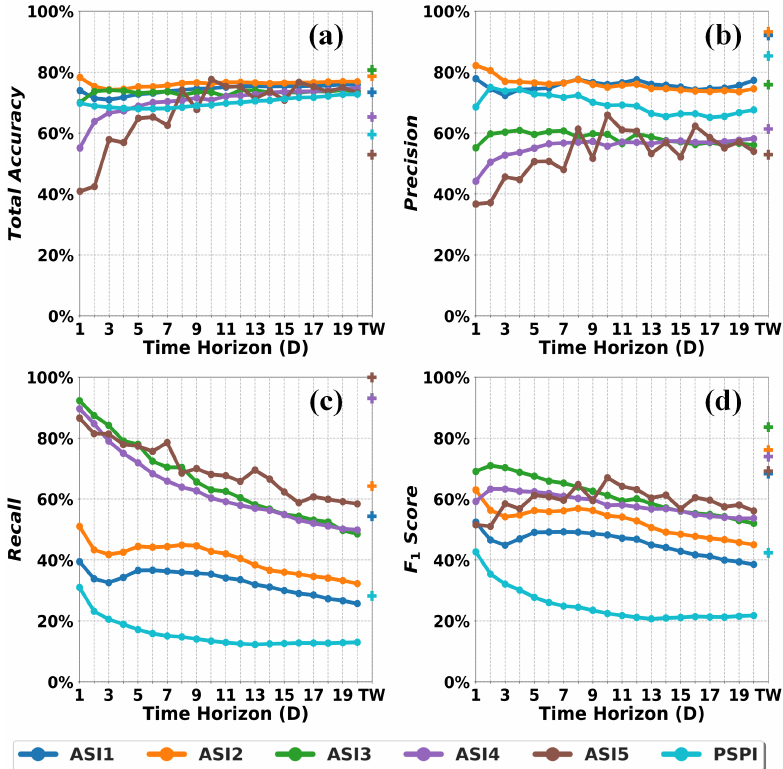
Figure 8. ( a ) Total Accuracy, ( b ) Precision, ( c ) Recall and ( d ) F 1 Score, for each ASI system and PSPI. Each metric is calculated at each time horizon D (solid lines) as well as at the 20 min time window analysis (TW + symbol). The definition of each metric is presented in Section 3.4. All metrics are presented as